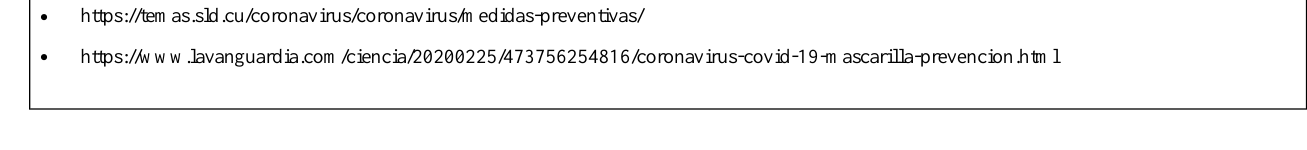
Table 1. Characteristics of the 80